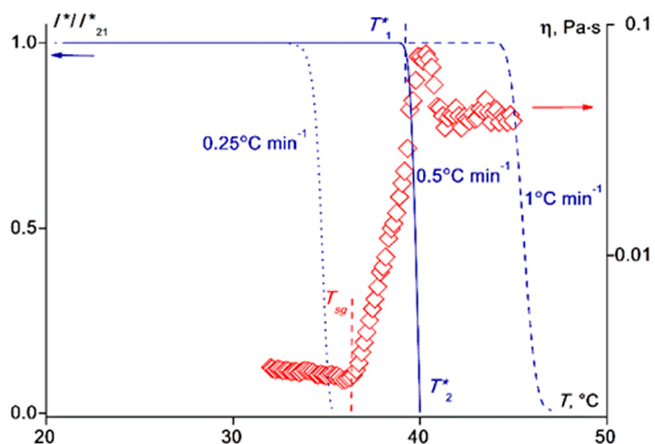
Figure 7. The temperature dependences of the relative optical transmittance (triangles) and the viscosity (lines) of the 15 wt.% CL-PiPrOx aqueous solution obtained at the heating rates 0.5 °C·min − 1 (triangles and solid line), 0.25 °C·min − 1 (dot line), and 1.0 °C·min − 1 (dash line).